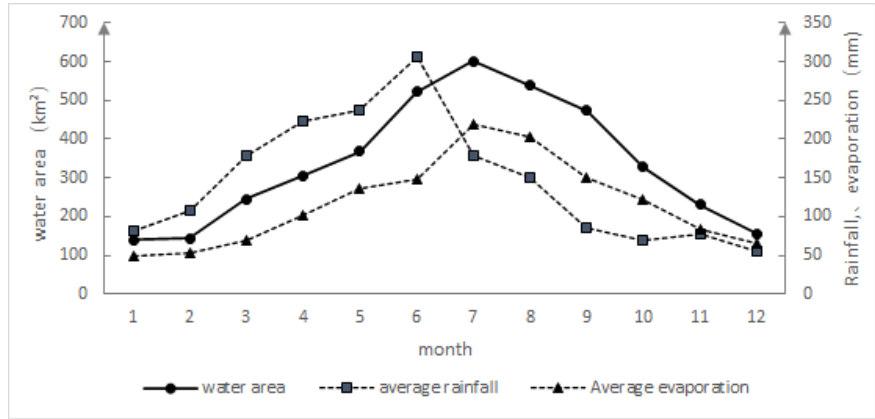
Figure 6. Comparison of monthly changes in rainfall evaporation and the water area of the seasonal lakes.